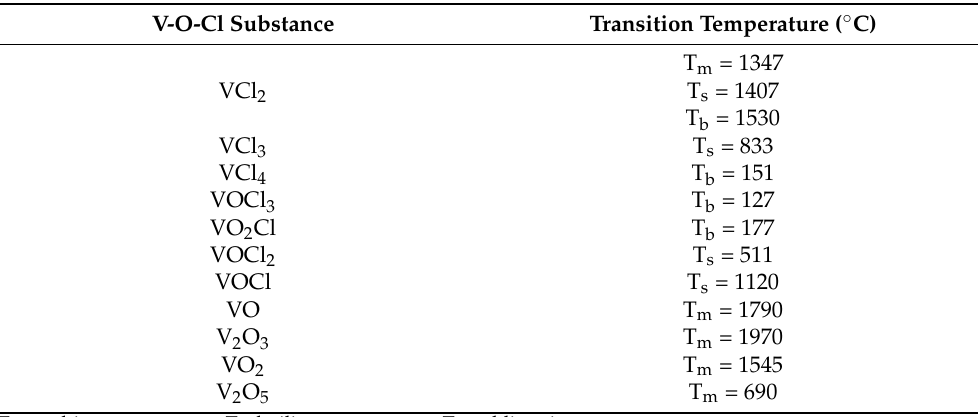
Table 1. Meltingtemperature, boilingtemperature, andsublimationtemperatureforvanadium compounds. V-O-Cl Substance Transition Temperature ( ◦